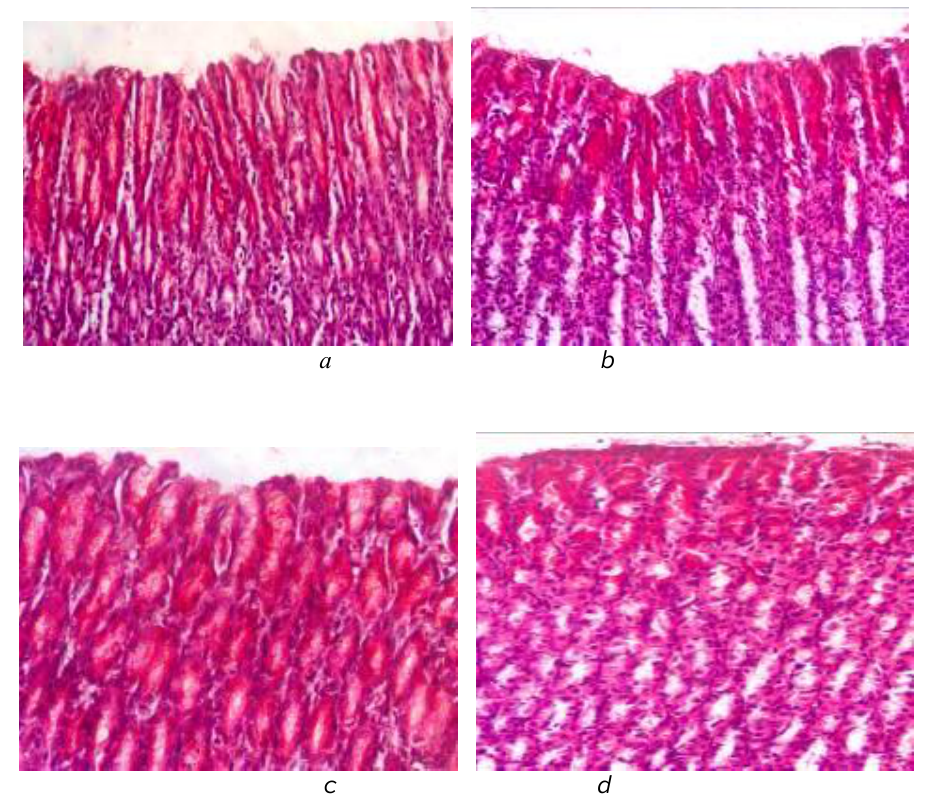
Fig. 12. The stomach of rats injected with dry extract of cabbage at a dose of: a – 30 mg/kg; b – 40 mg/kg; c – 50 mg/kg; d – 60 mg/kg on the background of an alcohol-prednisolone mixture. A distinct increase in the intensity of the PAS-reaction in mucus-forming cells of various parts of the mucous membrane. PAS-reaction. ×200